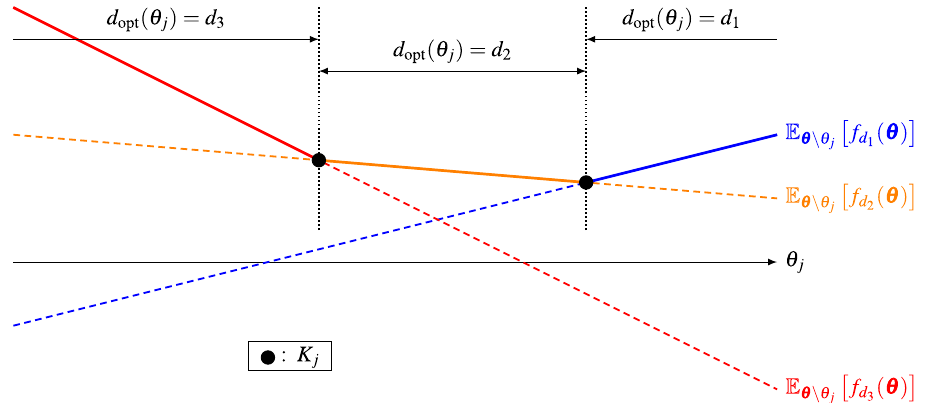
f d ( θ ) for different options d θ j \ (cid:31) (cid:30)